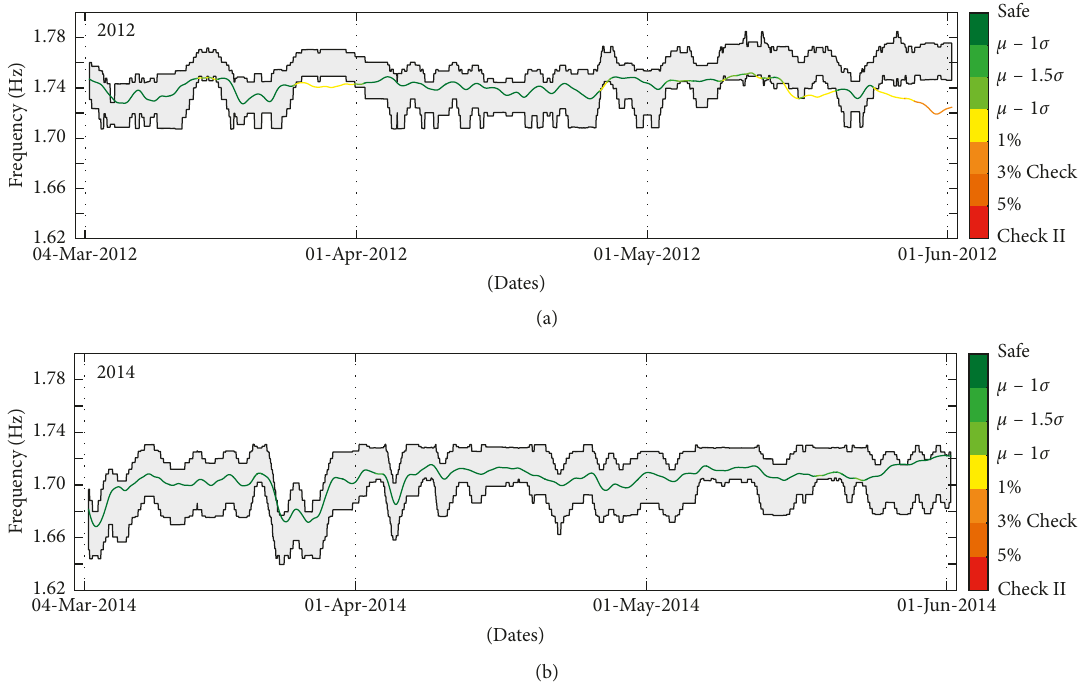
Figure 9: The traffic light concept applied in real time at the OT in 2012 (a) and 2014 (b). The color scale is defined in Figure 8. The shaded zone corresponds to 2 σ of the mean frequency defined during the learning ±